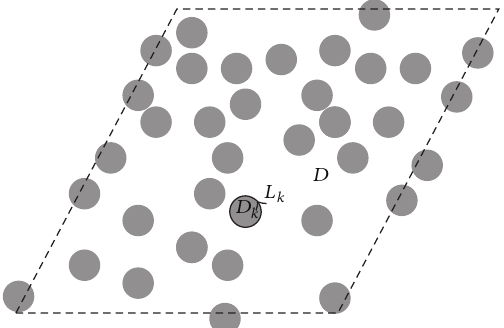
Figure 1: Random double periodic location of the nonoverlapping domains 𝐷 𝑘 (gray disks) bounded by 𝐿 𝑘 ; 𝐷 is the complement of all the closed domains 𝐷 𝑘 ∪ 𝐿 𝑘 to the periodicity cell 𝑄 (dashed